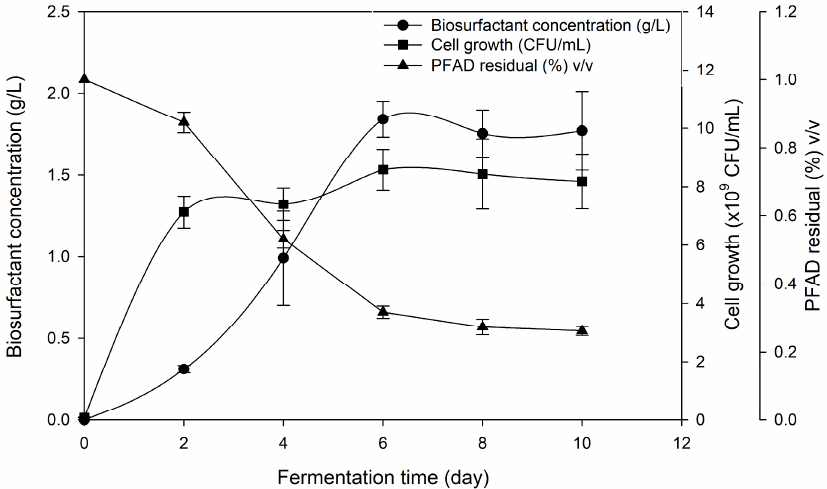
Figure 3. The profiles of microbial growth, biosurfactant production and PFAD residual in the broth during fermentation performed by Pseudomonas sp. LM19 grown in the optimized medium.